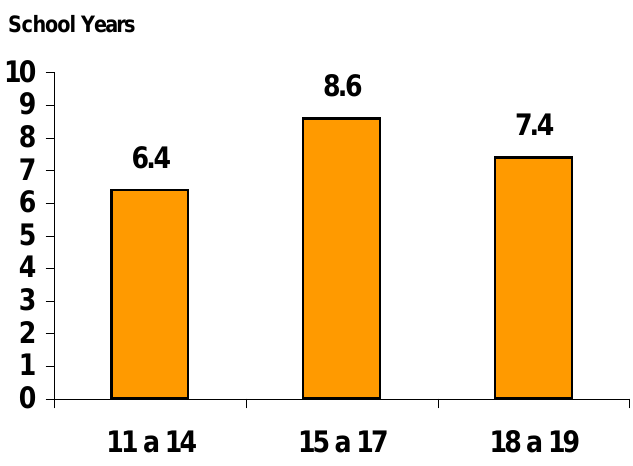
FIGURE 2. Average school years of pregnant teens attended at the Pediatrics Department at the University Hospital in Sao Paulo City by age groups.